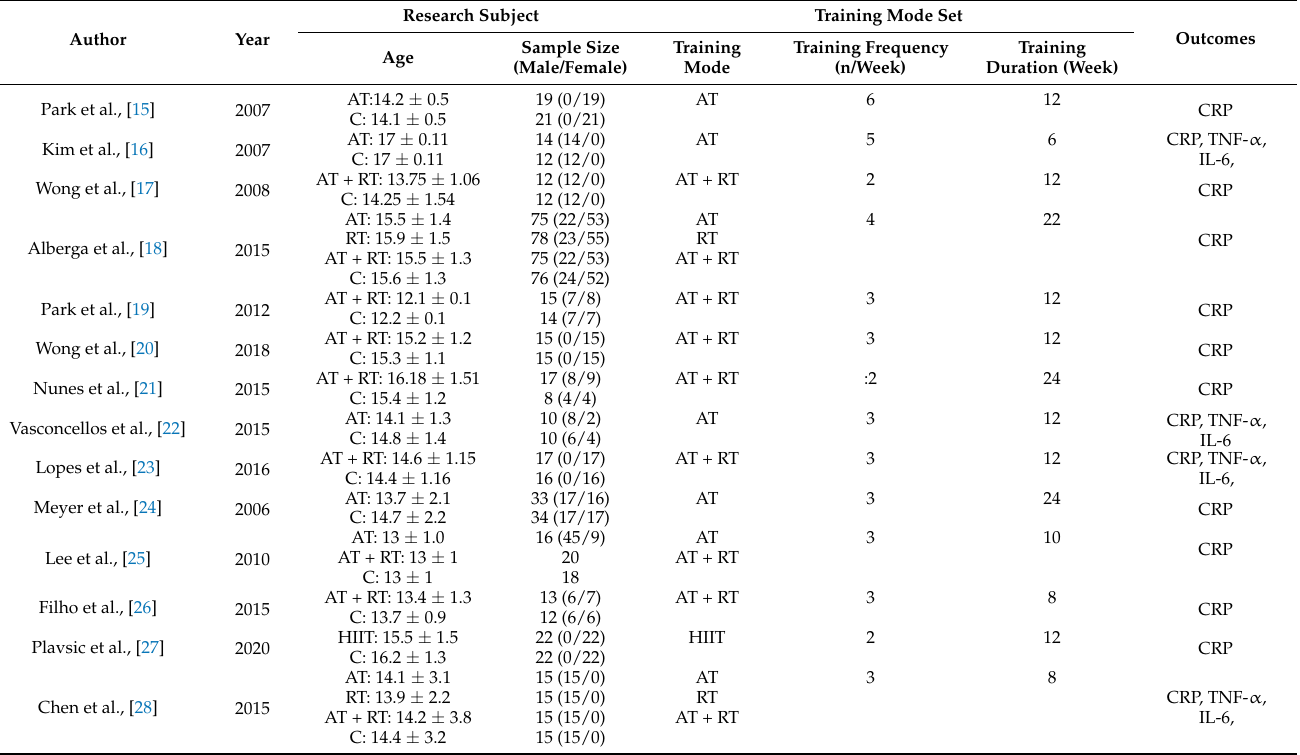
Table 1. General features of the selected research